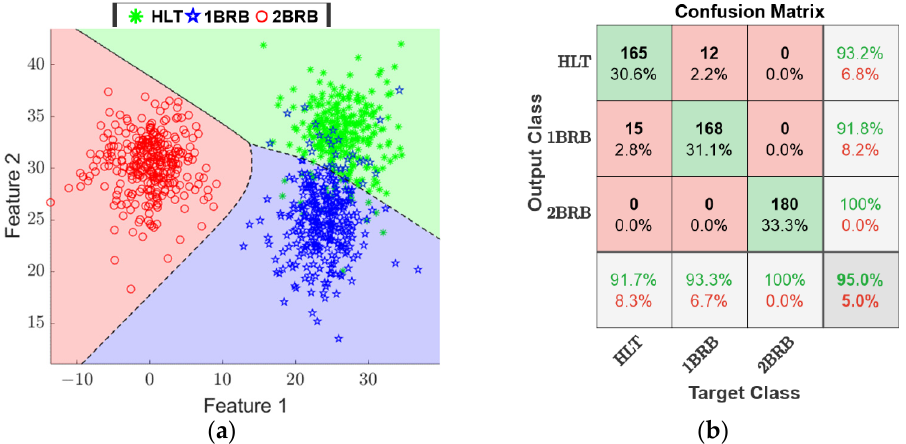
Figure 15. Classification results of the proposed methodology obtained for the Schneider soft-starter. ( a ) Resulting decision regions modelled by the proposed NN-based classifier over the 2-dimensional space; ( b ) Confusion matrix. Table 4. Overall classification efficiency of the proposed method for different mesh sizes, and for the different soft-starters